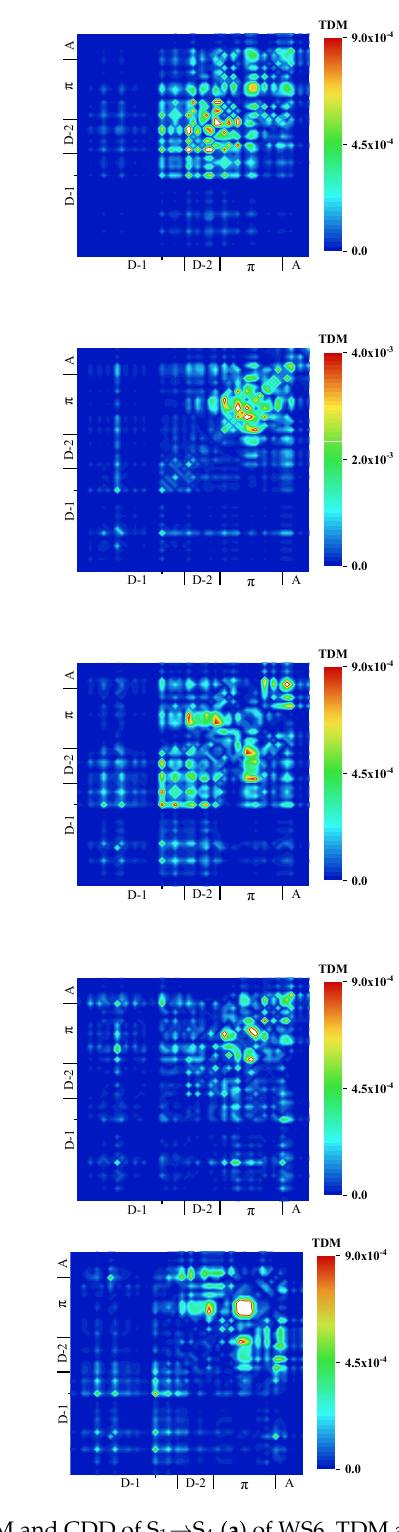
Figure 10. TDM and CDD of WS6 in TPA. TDM and CDD of S 1 → S 4 ( a ) of WS6, TDM and CDD of S 0 → S 3 ( b ) of WS6, TDM and CDD of S 3 → S 4 ( c ) of WS6, TDM and CDD of S 3 → S 12 ( d ) of WS6, TDM and CDD of S 3 → S 9 ( e ) of WS6.